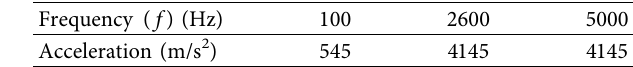
Table 2: ISO 19683 recommended shock